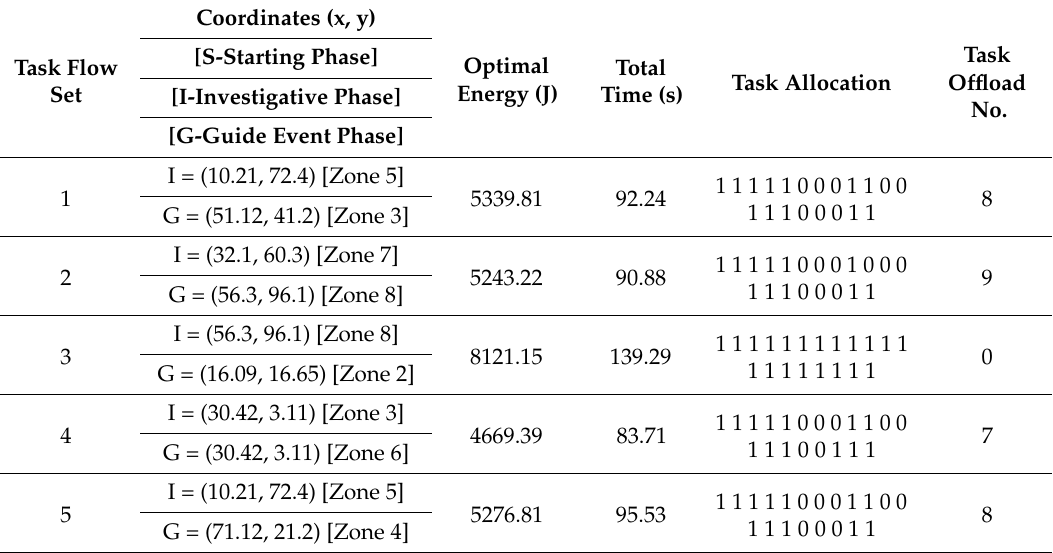
Table 7. Performance for GA-based task offloading for each task flow (minimise: E total ).